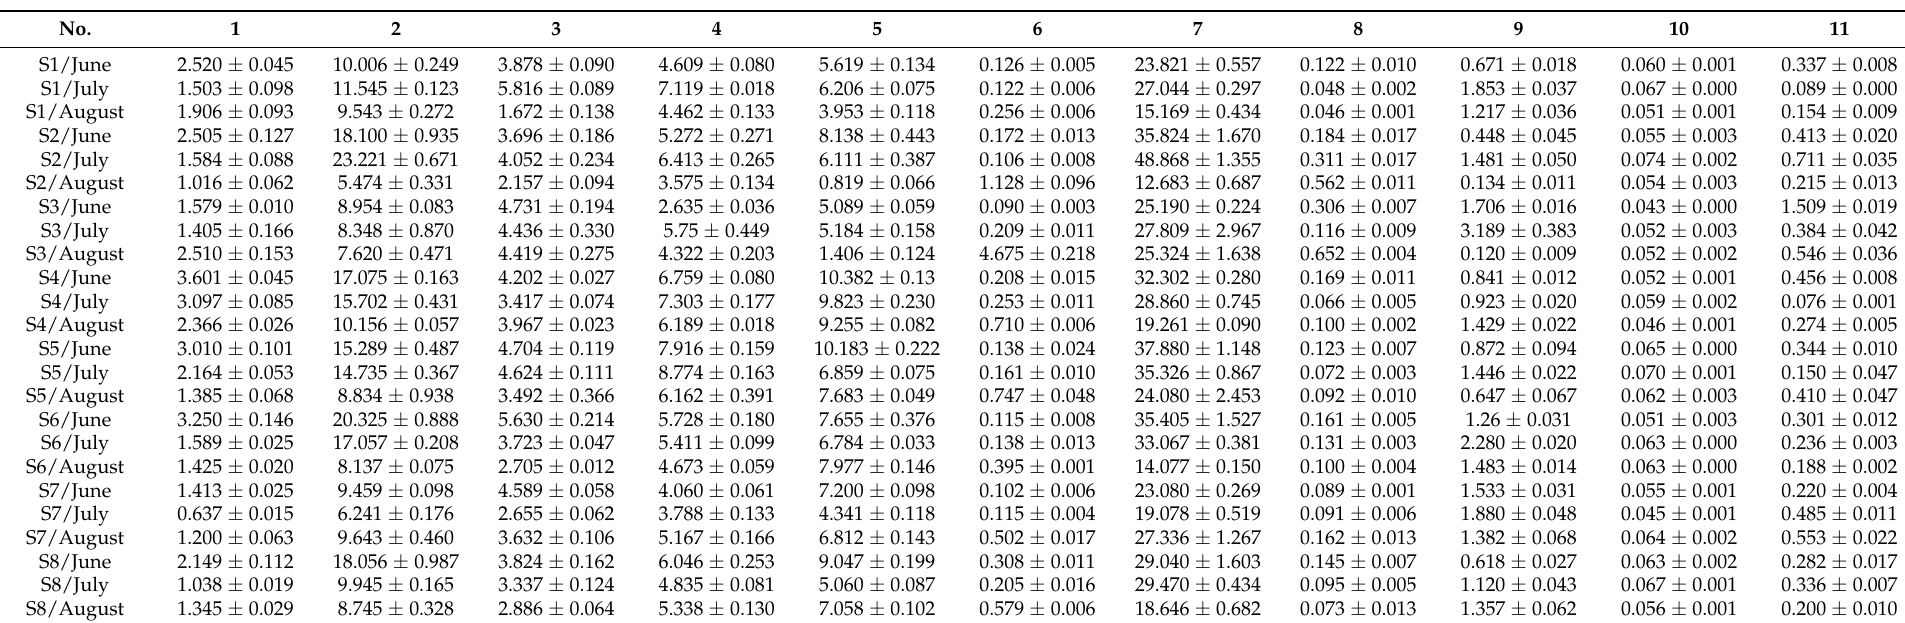
Table 4. Contents (mg/g) of the eleven representative components in the 24 batches of Clinopodium polycephalum